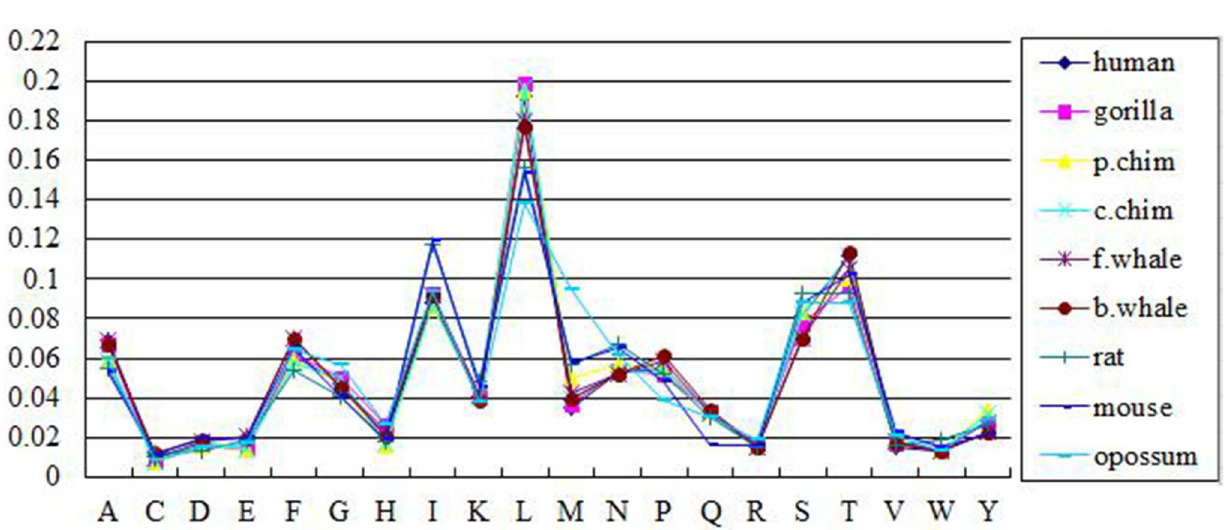
Fig 2. The position ratios of twenty amino acids in the ND5 dataset. The X axis denotesthe 20 amino acids and the Y axis denotesthe positionratios of each amino acid for 9 sequences.